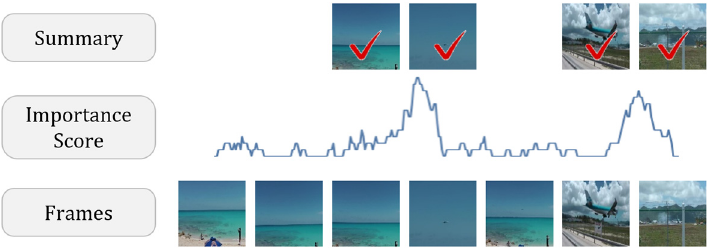
Figure 1. Overview: Our goal was to predict the accurate importance score of the keyframes to produce a summary.